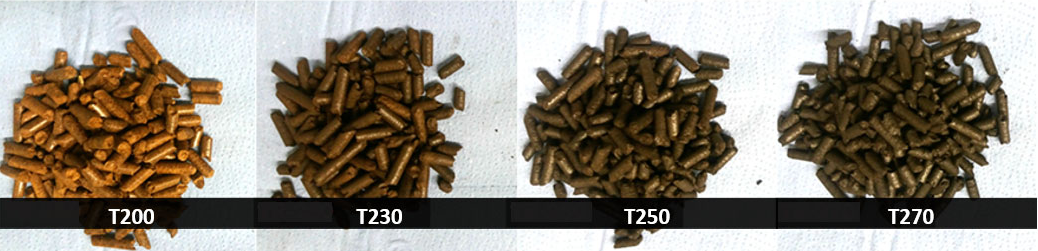
Figure 4. Torrefied wood pellets obtained from torrefaction process.